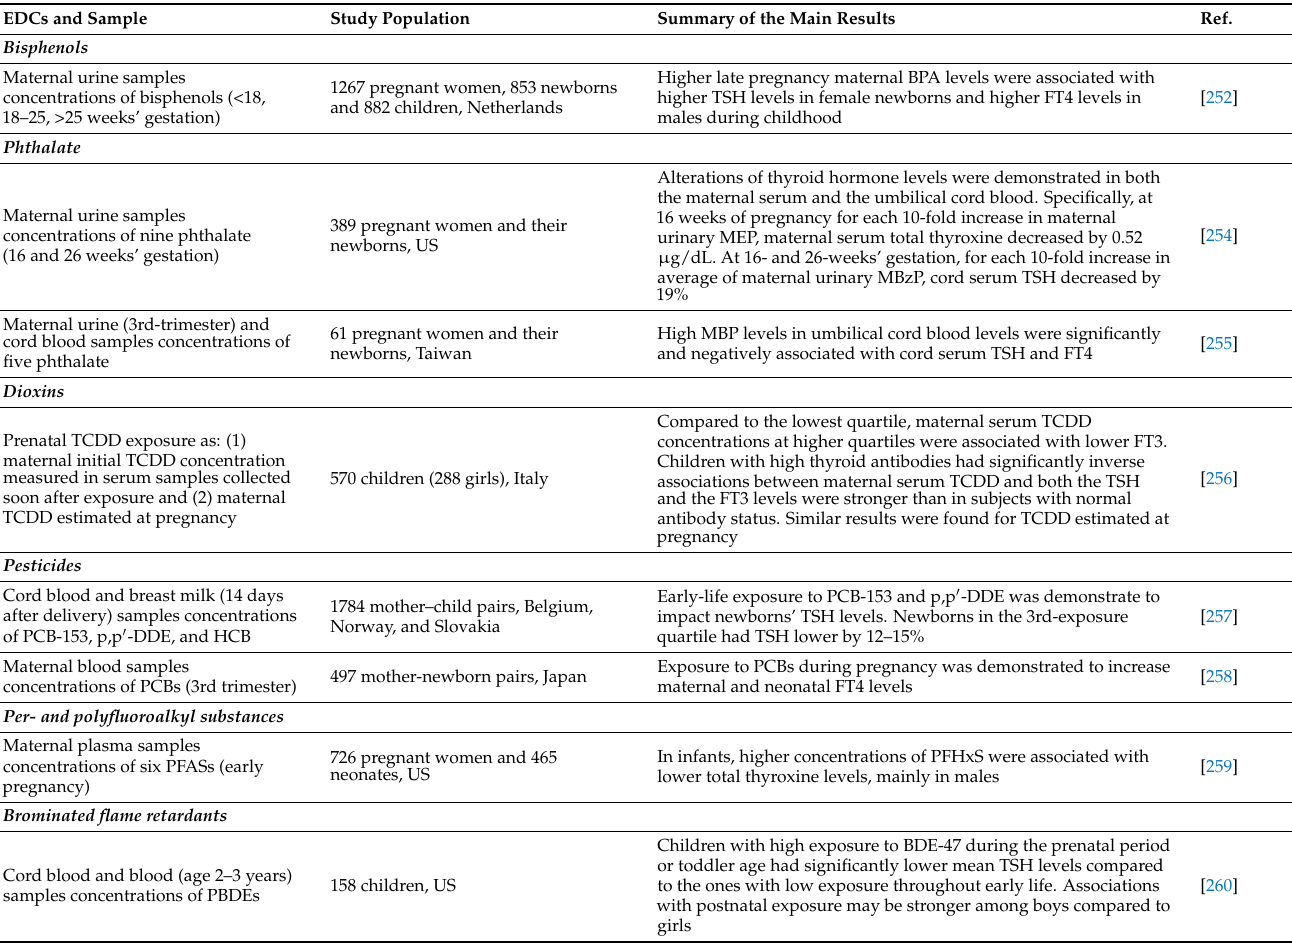
Table 7. Epidemiological data from some studies on thyroid